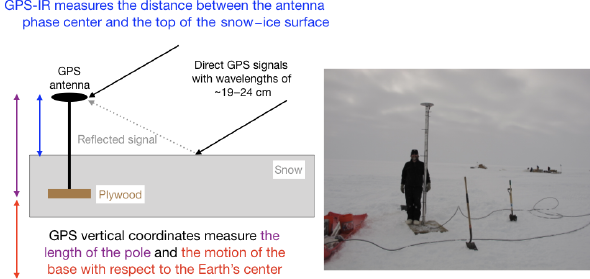
Figure 1. On the left GPS-IR geometry is shown along with a draw- ing of a typical GLISN installation. The reflected signal (in gray) interferes with the direct signal (black), which creates an interfer- ence pattern directly related to the reflector height (blue). The latter is defined as the distance between the GPS antenna phase center and the top of the ice–snow surface. The GPS vertical coordinates are defined relative to the center of the Earth. On the right is a photo- graph of GPS station GLS1 in 2011. The GPS antenna is attached to a monument made of plywood, buried 1.5m below the surface at installation. Photo courtesy of IRIS.